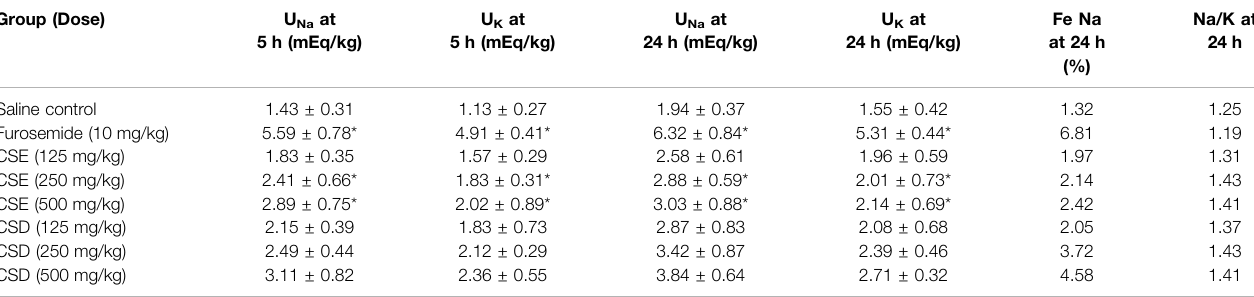
TABLE5| Effectofthecherrystemsextract(CSE)andcherrystemsdecoction(CSD)onurinaryexcretionofsodium(U Na )andpotassium(U K )5and24 hafterthesubstance administration, fractional excretion of sodium (FE Na ), and the ration Na/K in saline loaded Crl:WI rats. Group (Dose)